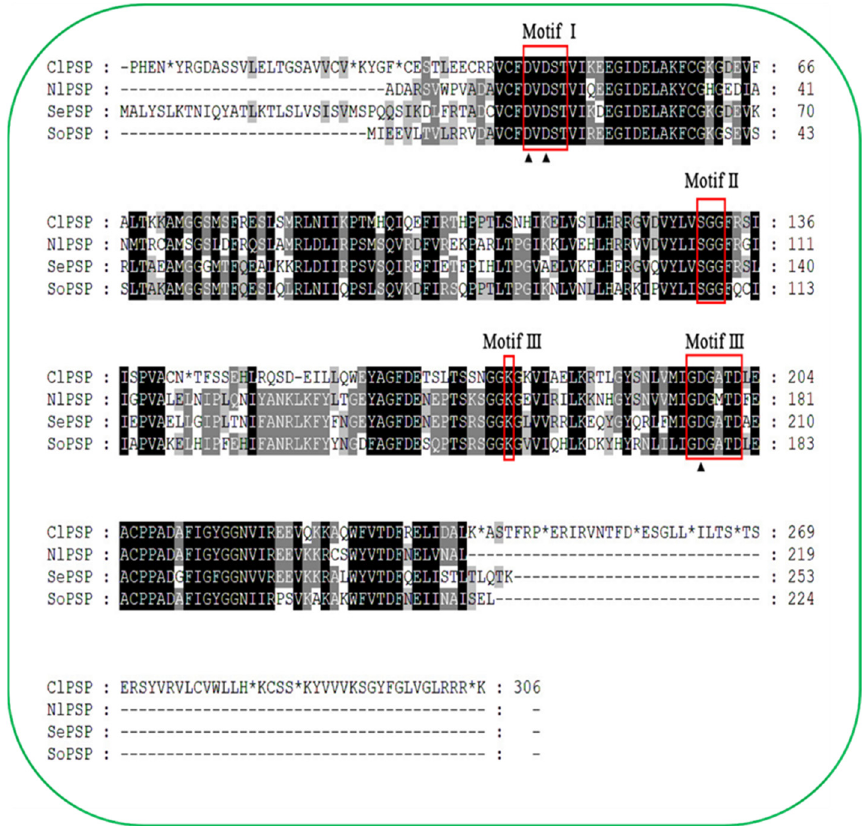
Figure 1. Amino acid sequence alignment of C. lividipennis phosphoserine phosphatase (ClPSP) with its homologous PSPs originating from N. lugens (NlPSP, AGG09860), S. exigua (SePSP, KAF9423892), and S. oryzae (SoPSP, XP_030747197). Identical amino acids are shaded, whereas the gaps have been introduced to permit alignment. The red boxes indicate the conserved motif. The amino acid residues labeled with black triangles show the metal-binding sites.